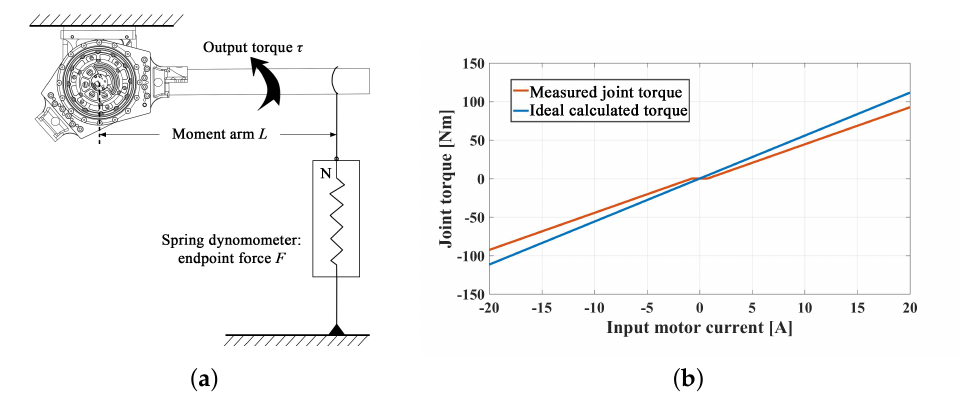
Figure 2. ( a ) Output torque test setup; and ( b ) relation between output torque and input current in actuator. The blue and red lines are theoretically calculated data and fitting result of actual measured value, respectively. We can consider that the actuator is sufficiently linear but still has certain friction in reducer part. Because of the limitation of the experimental facility, this test only recorded the results in a limited range (from − 20 to 20 A), while the relation outside the range is considered as the